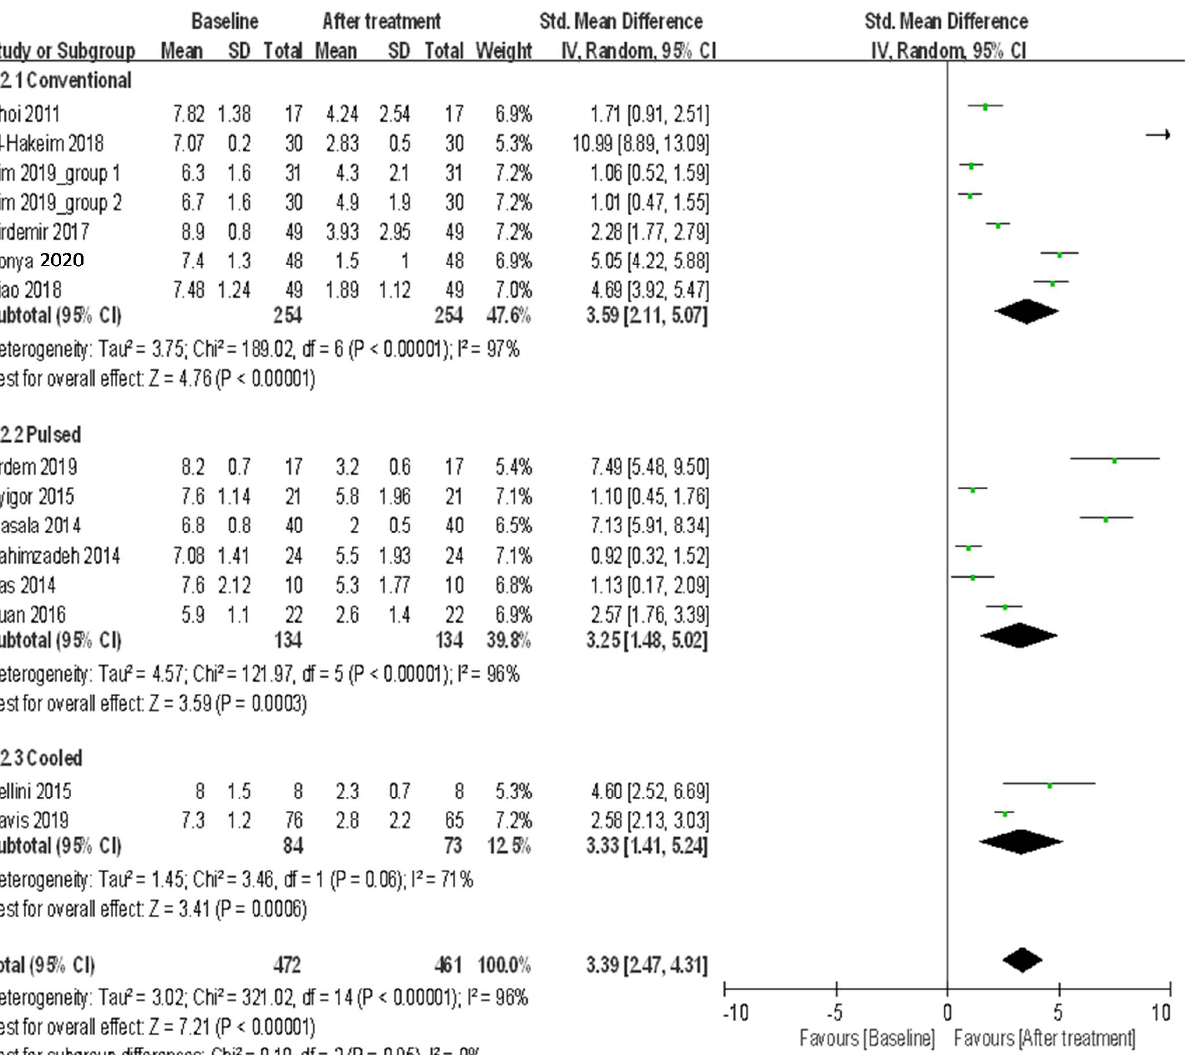
Figure 3. Meta-analysis of efficacy in pain using three radiofrequency ablation techniques to treat knee OA at the 3-month